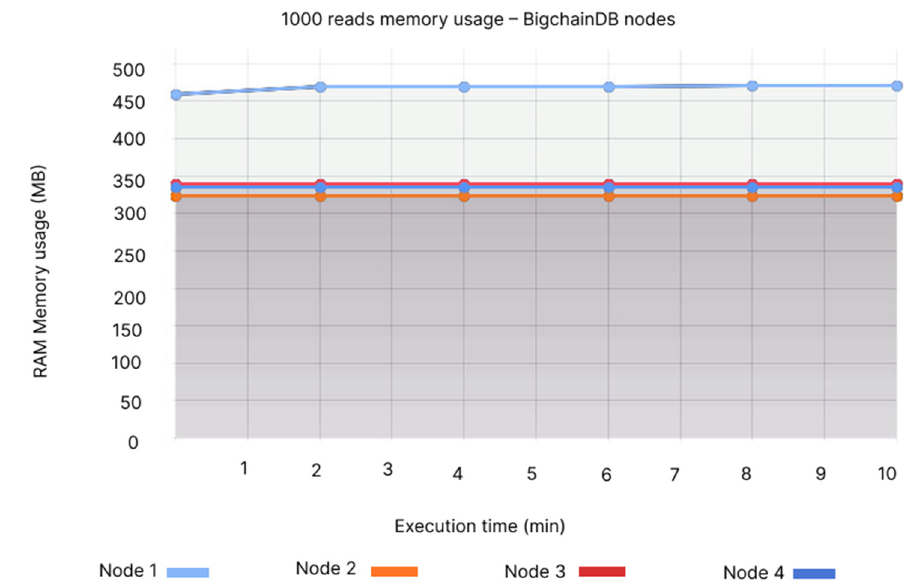
Figure 20. 1000 reads memory usage—BigchainDB nodes.